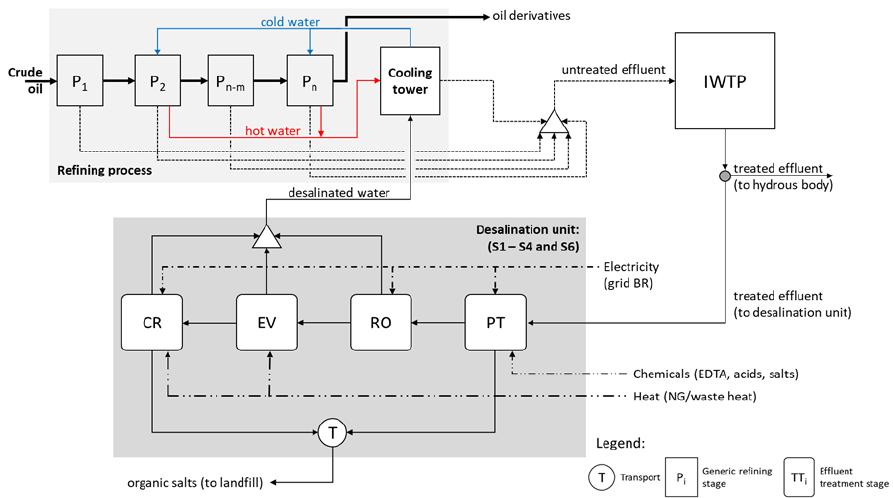
Figure 1. General view of effluent recovery systems (S1–S4 and S6) for reuse in a cooling tower.